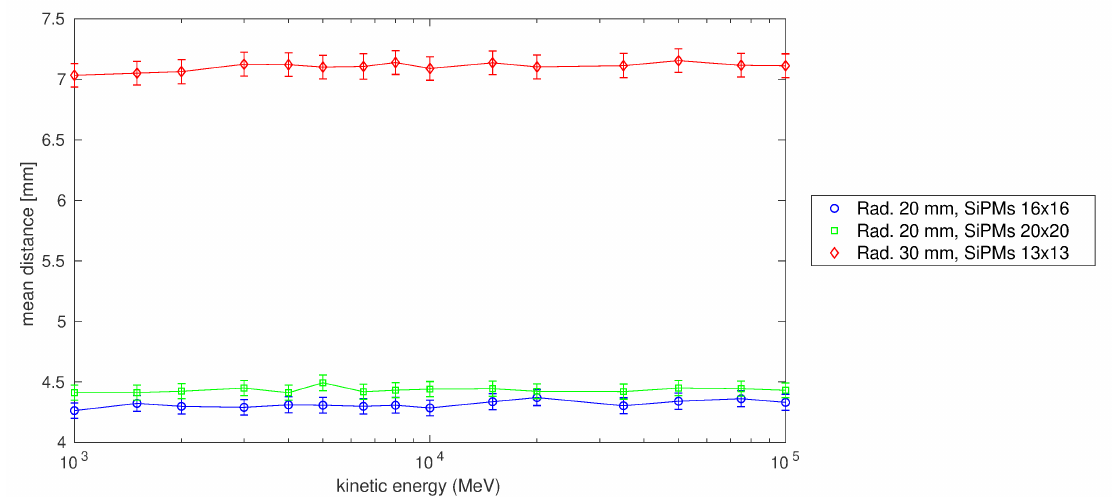
Figure 4. Mean distance between muon exit point from the radiator and 2D Gauss fit centroid in mm, for energies from 10 3 MeV to 10 5 MeV. In the legend are reported the radiator width in mm and the number of SiPMs in the array of sensors on the opposite face of the two radiator. The vertical error bars are equal to ± 3 σ standard deviation of each mean distance